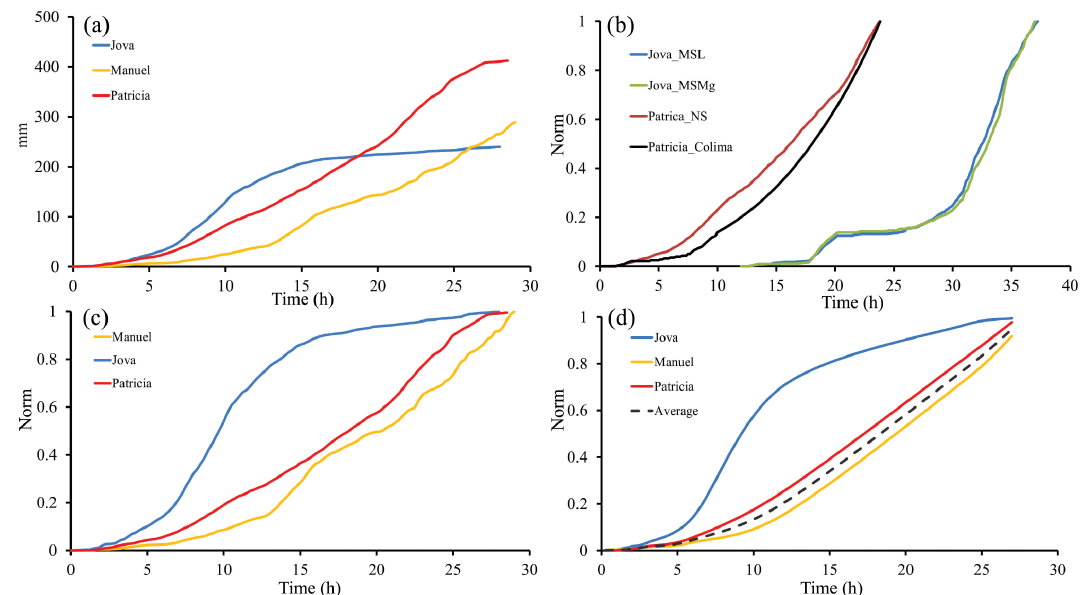
Figure 3. (a) Cumulative values of rainfall of hurricanes Jova, Manuel and Patricia calculated at 10min intervals. (b) Normalized rainfall curves for the Jova and Patricia events as gathered from two different stations, pointing to a quasi-stationary rainfall behavior. (c) Normalized values of cumulative rainfall curves. (d) Normalized curve of total rainfalls cumulated at 15, 30, 60min and 1, 3, 6, 12, 18, 24, 27h. Dotted line represents the average value between hurricanes Manuel and